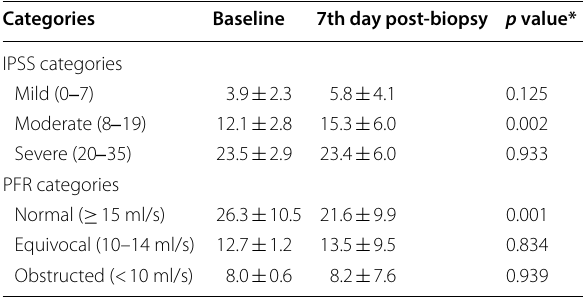
Table 3 Comparison of the baseline and 7th day post- biopsy total IPSS and PFR in patients with different